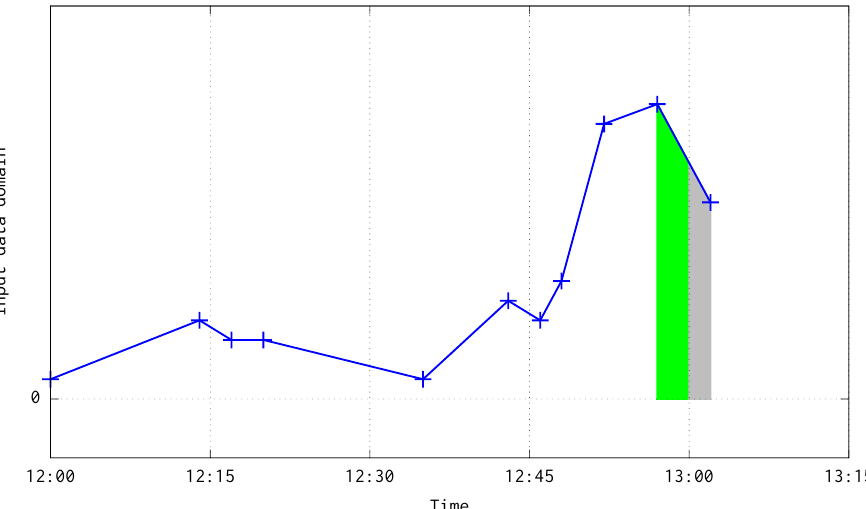
Figure 5. Illustration about the integration process of previous and current input data pairs when both are in different but in consecutive quarters. In green color has been shown the interpolation computed until 13:00, ending a quarter mean value computation. In gray color has been depicted the interpolation that would be aggregated to the quarter ending at